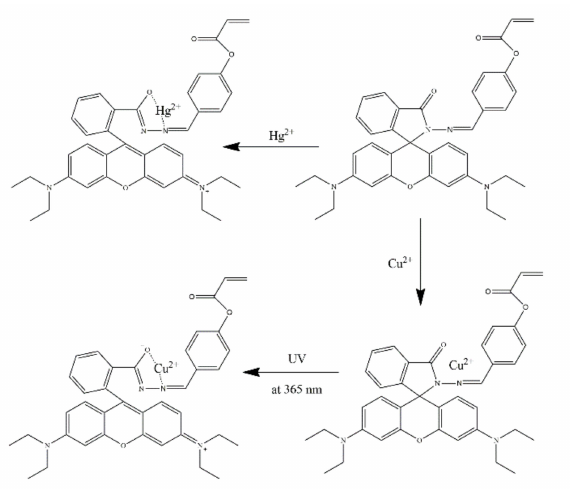
Figure 50. The sensing mechanism of RhBH-HB-Ac (Table 4, No. 1)